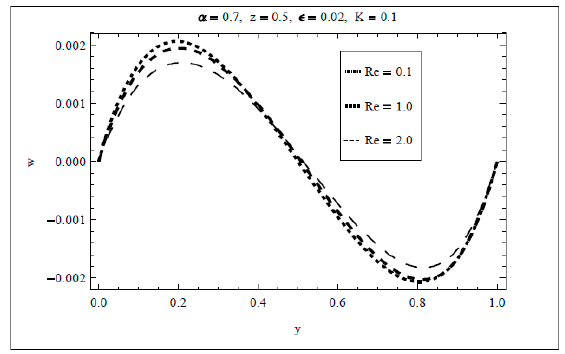
Figure 10. Effect of Re on cross-flow velocity w along y .